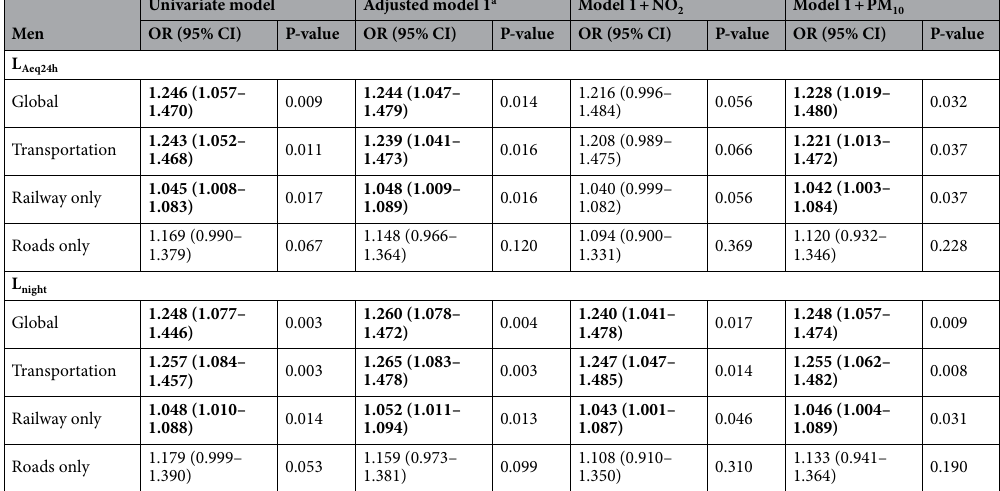
Table 3. Associations between noise exposure and risk categories of TRS-2P score, stratified by sex: men’s table. Odds ratios associated to noise exposure expressed for an increase of 10 dB(A). OR odds ratio, CI confidence interval. Significant values are in bold. a Model 1: Model adjusted on socio-economic level and cardiac